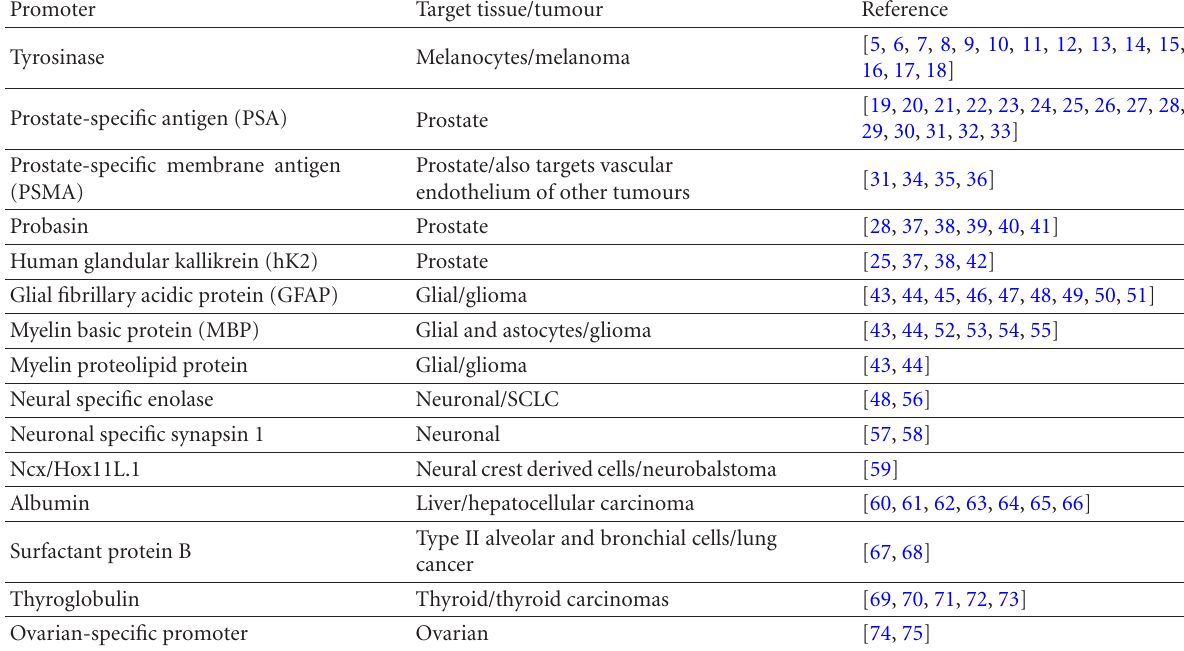
Table 1. Tissue-specific promoters used in cancer gene